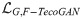
The evaluation results comparing different loss functions on four different data sets, according to the LPIPS metric.Loss-TecoGAN represents the loss function LG,F−TecoGAN, whilst Loss-MRMVSR represents the loss function LG,F−MRMVSR.